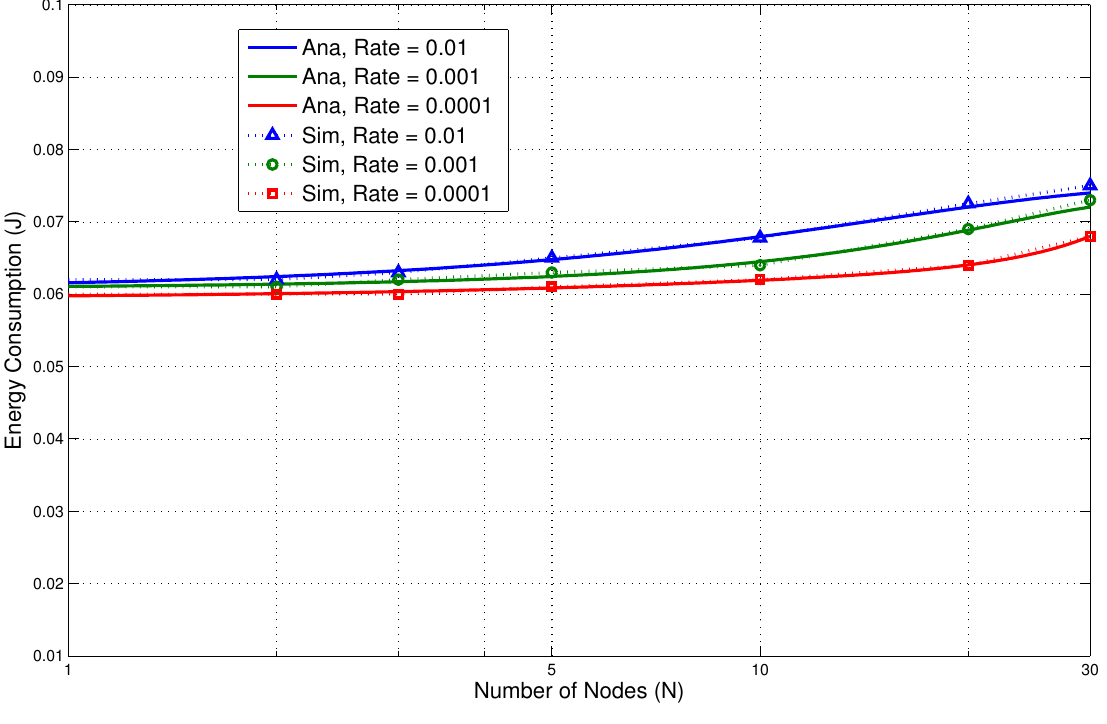
Figure 17. Emergency traffic energy consumption.